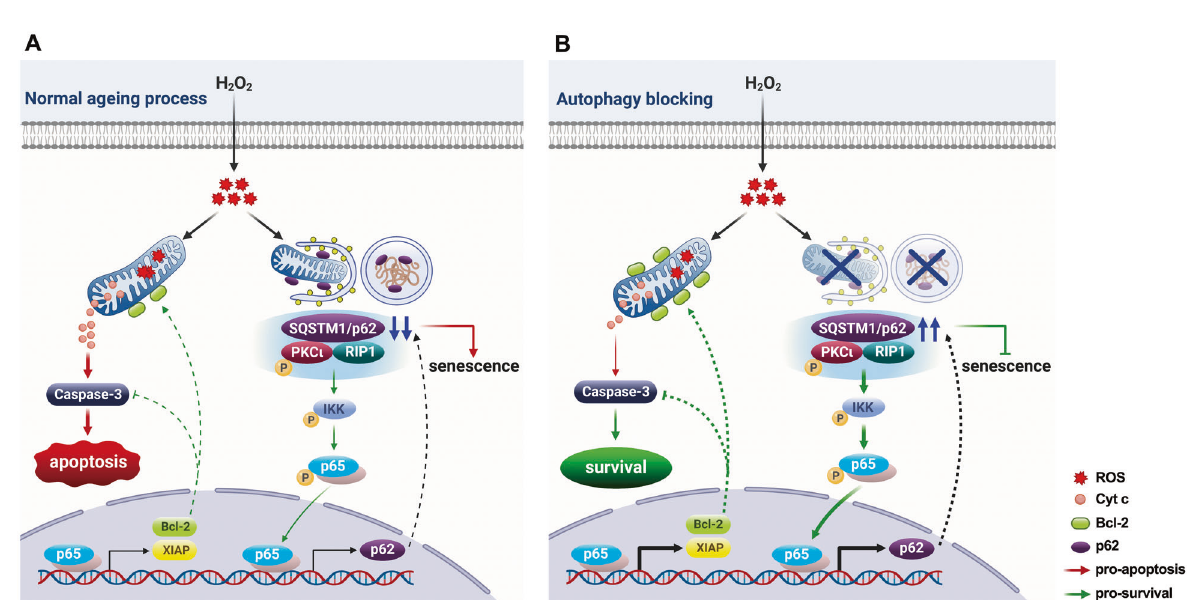
Fig. 8 Working model illustrating the role of autophagy in oxidative stress-induced senescence and cell death. A Oxidative stress triggers durable autophagy in human LECs which leads to excessive degradation of p62 protein, and subsequently results in premature senescence. Low level of p62 scaffold protein can not sustain the pro-survival PKC ι -IKK-NF- κ B signaling, and hence facilitates apoptosis induced by oxidative stress. B Autophagy is inhibited by genetic deletion of the Atg gene or a chemical inhibitor. The elevated level of p62 delays the senescence process, and antagonizes pro-apoptotic signaling via boosting the suf fi cient pro-survival signaling PKC ι -IKK-NF- κ B cascades. Universal SYBR Green RT-PCR Kit (Cat.# 1725122, Bio-Rad) and a CFX96 Real-Time PCR Detection System (Bio-Rad). The primer sequences are listed in Table S4. All samples were run in triplicate and data were normalized by the β -actin mRNA level. The experiments were repeated at least three times. Co-immunoprecipitation and Western blot HLE-B3 cells were cultured in 10 cm plates (3 × 10 6 cells) for 24 h and exposed to 200 μ M H 2 O 2 for the desired period of time. Cells were collected and lysed in ice-cold NP-40 buffer (Cat.# P0013F, Beyotime) containing 1 mM PMSF (Cat.# ST506, Beyotime) and Phosphatase Inhibitor Cocktail (Roche, 4906837001). The lysates were reacted with 2 μ g/ml of different antibodies (anti-p62, PKC ι , RIP1, or TRAF6 antibodies, Table S3) and incubated overnight at 4 °C. Then protein G dynabeads (Cat.# 78609, Thermo) were added, incubated for another 2 h at RT, and washed at least three times with IP buffer. Immuno-precipitated samples were run on SDS- PAGE gel and immunoblotted. For Western blot, cell lysates were prepared using RIPA buffer (Cat.# 9806, Cell Signaling Technology, MA, USA) containing PMSF and Phosphatase Inhibitor Cocktail. Protein concentrations were determined using a BCA Protein Assay Kit (Cat.# CW0014S, Cwbio, Beijing, China). The protein samples were separated by 8 – 12% SDS-PAGE gel and then electrotransferred to PVDF membranes (Cat.# IPVH00010, Merck Millipore, Germany) for 1.5 h at 0.3 A current. The membranes were blocked in 5% skimmed milk in TBST (0.05% Tween-20 in Tris-buffered saline) for 1 h at Cell Death and Disease (2022)